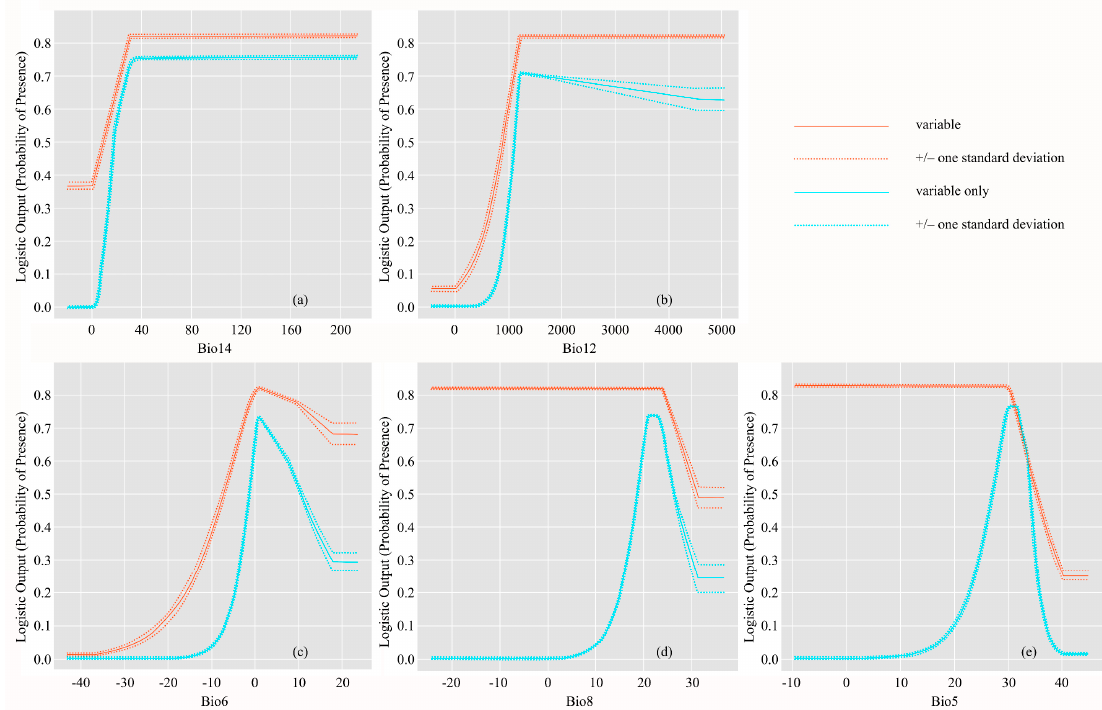
Table 3. Contribution (i.e., important) parameters of the five climate variables included in the optimal model.